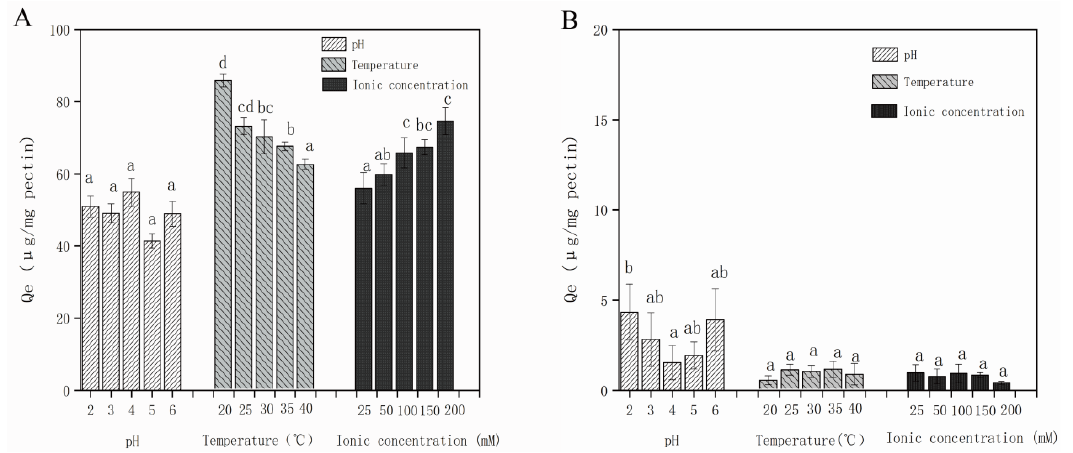
Figure 2. Effect of solution conditions on adsorption capacity of EC ( A ) and CA ( B ). Different letters represent significant differences ( p < 0.05). EC: epicatechin; CA: chlorogenic acid.